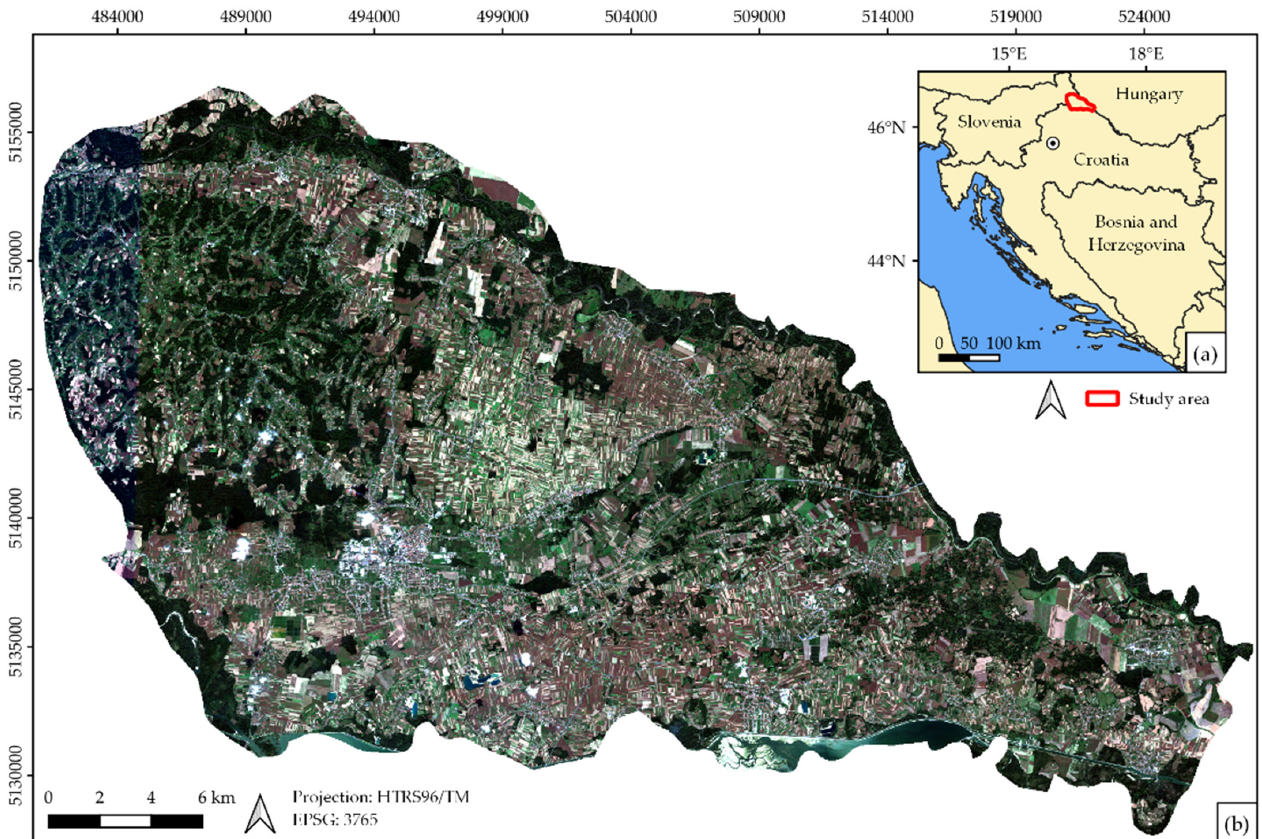
Figure 1. ( a ) Location of the study area and ( b ) overview of the study area (background: true-color composite of Sentinel-2 imagery; bands: B4-B3-B2, acquisition date: 28th September 2018).